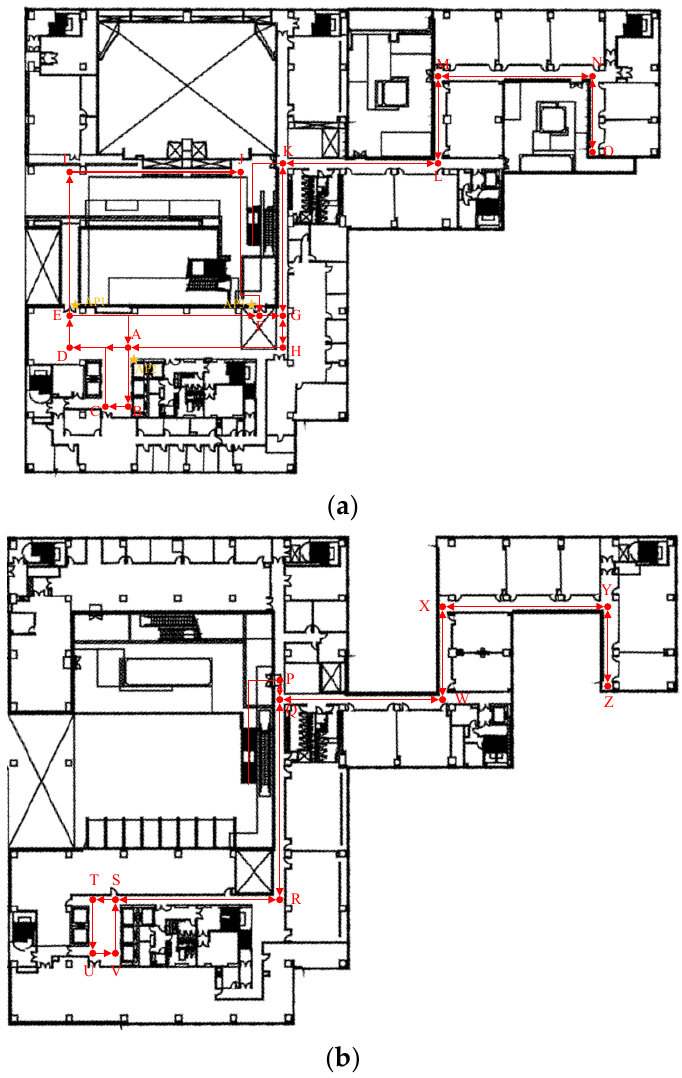
Figure 14. ( a ) Walking route at 4th floor; ( b ) walking route at 5th floor. (A–Z indicate the ground-truth turning points of walking route, red arrows indicates the moving direction).